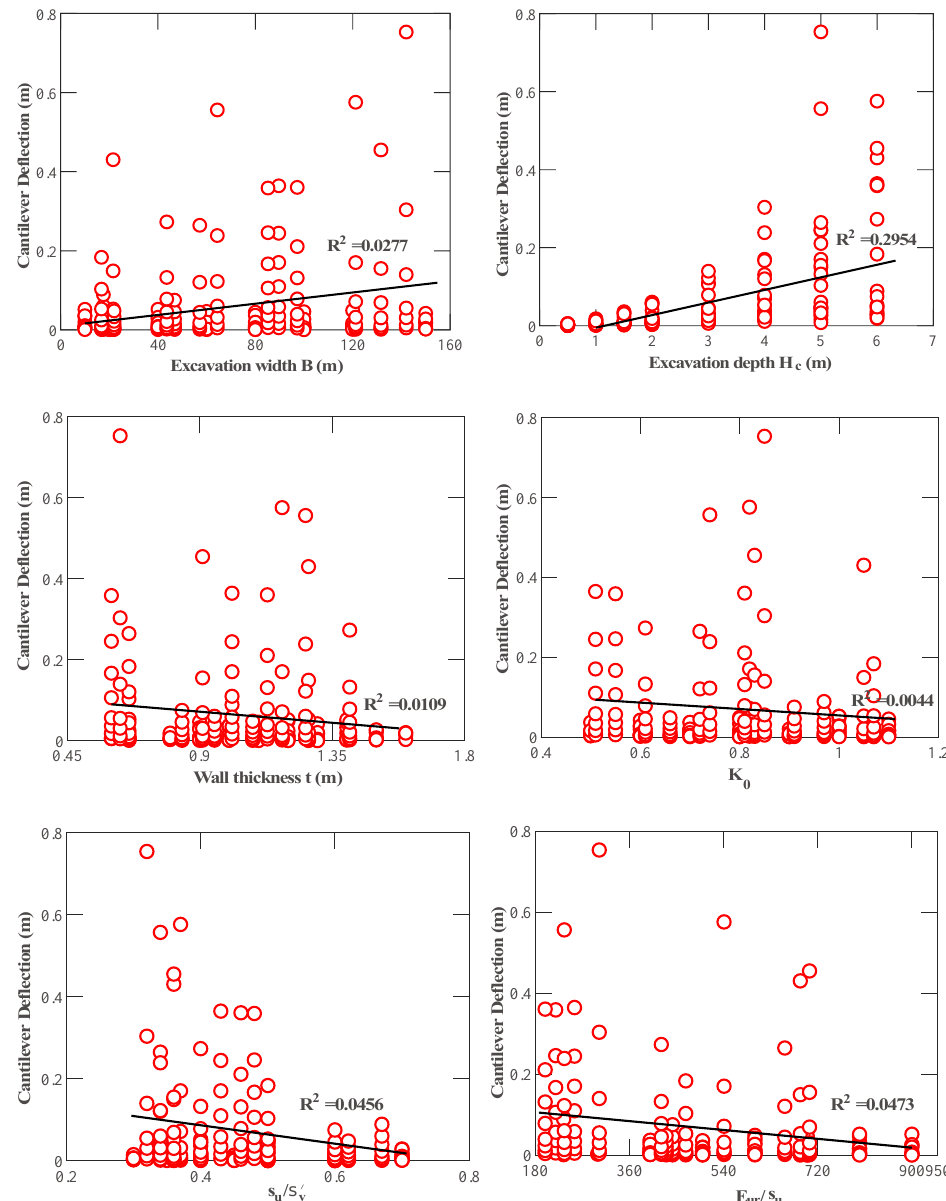
Figure 3. Relationship between input and output parameters.